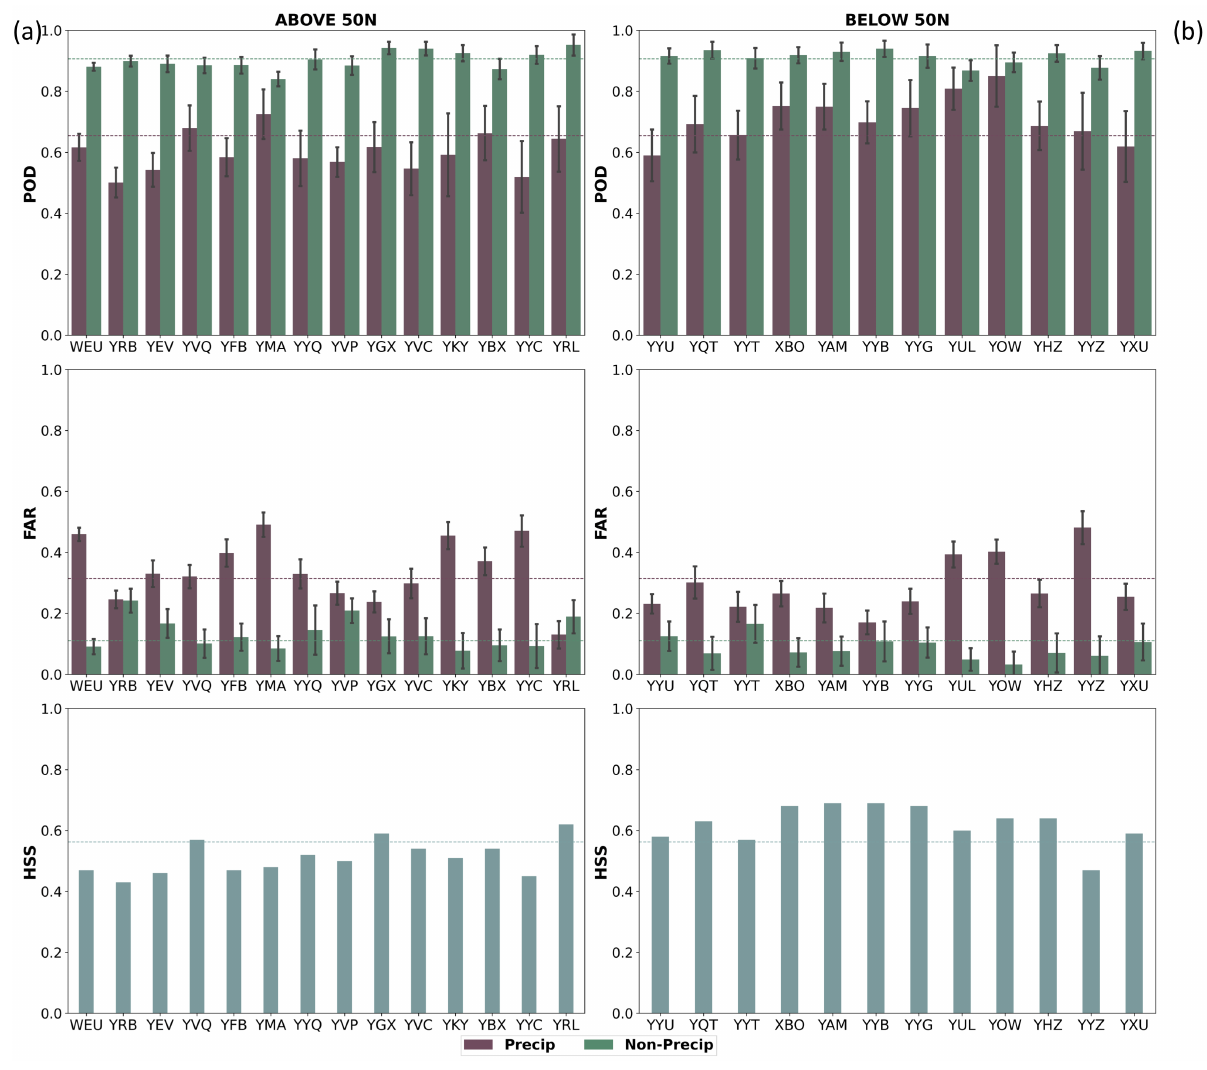
Figure 6. Same as the leftmost column in Figure 3, except here each metric is shown for all 26 ECCC weather stations (Table 3). The stations are grouped by latitude: ( a ) all stations > 50 ◦ N; and ( b ) all stations < 50 ◦